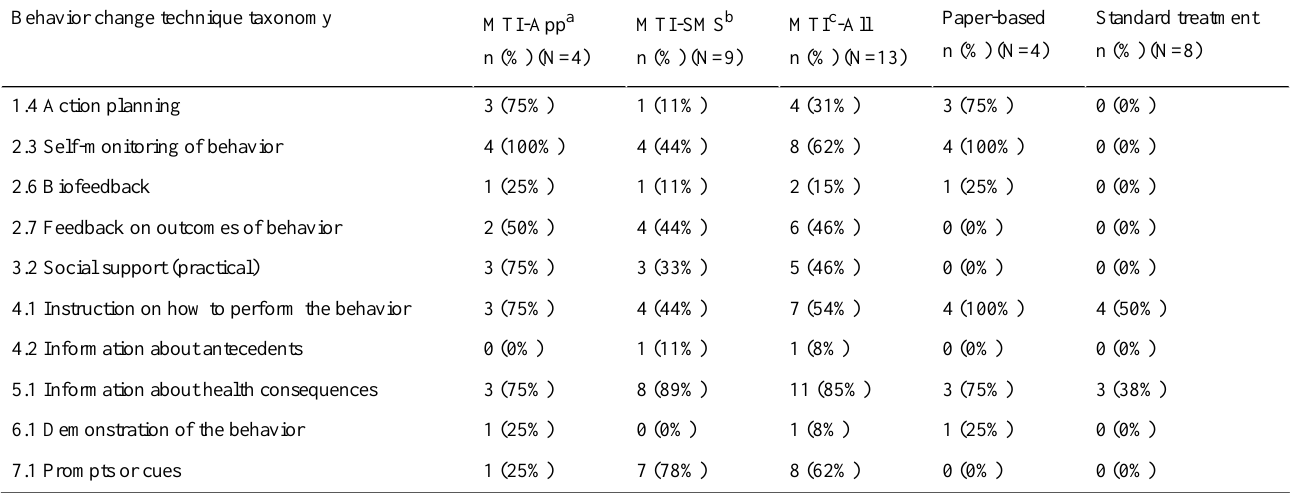
Table 3. Behavior change technique taxonomy used by study group.